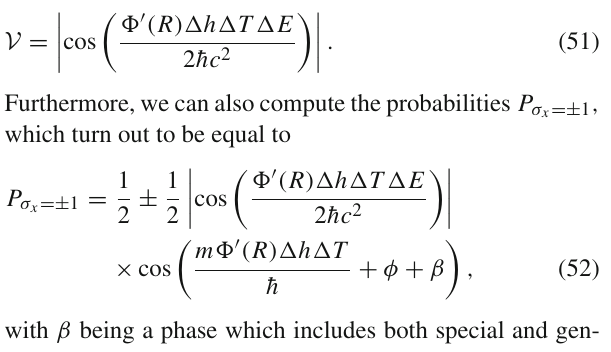
The term (cid:14)ϕ := m (cid:15) (cid:19) ( R )(cid:14) h (cid:14) T / ¯ h ∼ O ( c 0 ) is the